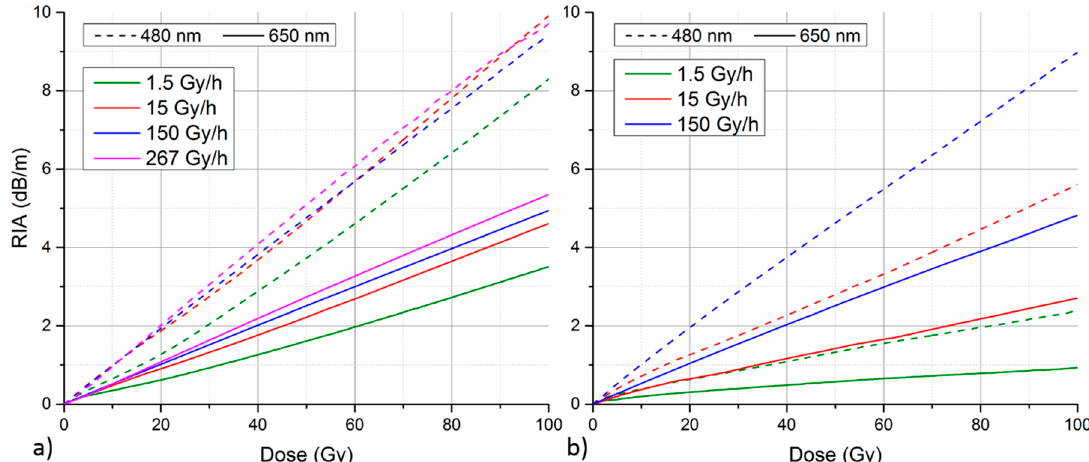
Figure 3. RIA of GigaPOF-50SR ( a ) and Fontex ( b ) PF-POF as a function of total radiation dose measured at different irradiation dose rates. RIA growth at two selected wavelengths is compared.